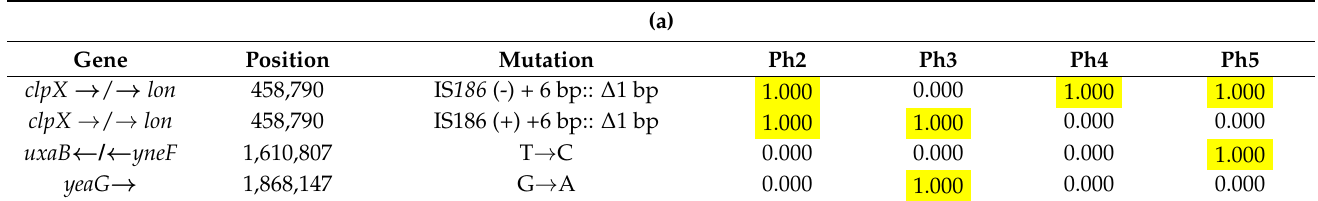
Table 4. ( a ) Position of selective sweeps (yellow) and significant polymorphisms (green) in phage- resistant populations at day 35. ( b ) Annotation of genes mutated (red-nucleotides changed) in phage-resistant populations at day 35. Selective sweep is determined by an increase in frequency of a de-novo mutation to 1.000. A significant polymorphism is determined by an increase in frequency of a de-novo mutation between 0.500 to 0.999. Stop codons are symbolized as *.